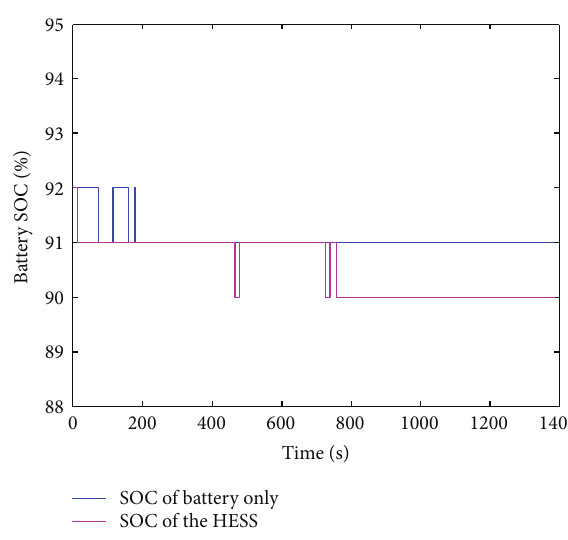
Figure 18: Comparison of the battery SOC